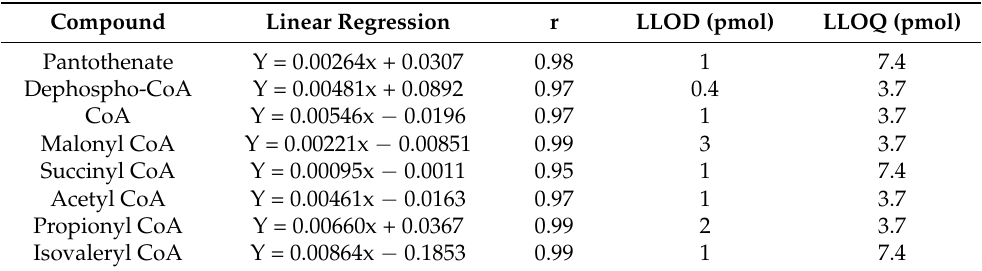
Table 3. The lower limits of detection (LLOD) and quantitation (LLOQ) are calculated as described in the